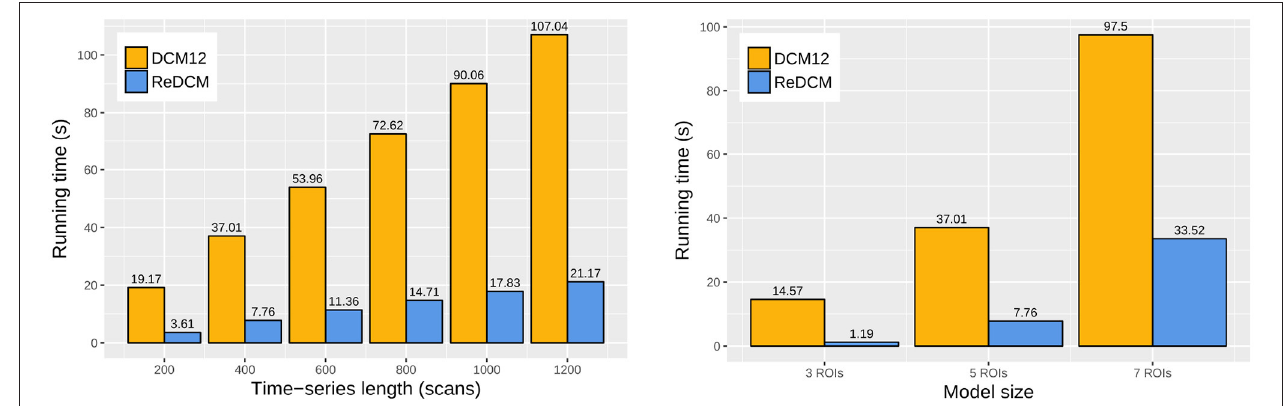
FIGURE 3 | Runtime comparison of DCM12 and ReDCM. We measured the average one-threaded computation runtime of the variational update cycles for both implementations. The comparison was based on varying scan length (200, 400, 600, 800, 1,000, and 1,200 frames) of a DCM model with five regions of interest (ROIs), and different model sizes (3, 5, and 7 ROIs) fitting fMRI data with scan length of 400 frames. There is a linear dependence between scan length and runtime, however, computations are exponentially longer with higher model sizes.